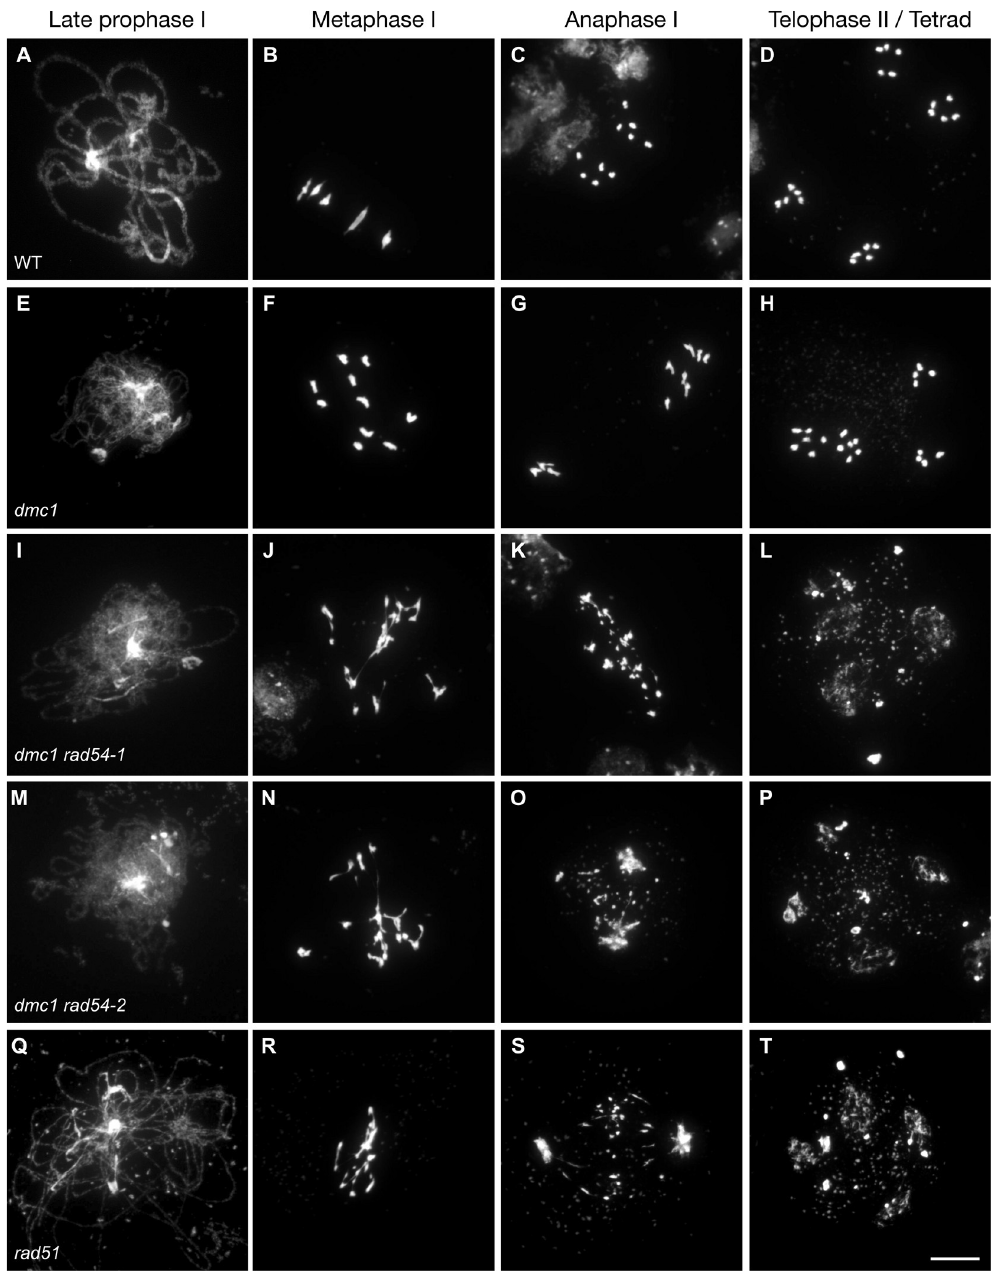
Fig 4. Absence of RAD54 leads to chromosome fragmentation in dmc1 meiosis. Male meiosis is shown in (A-D) wild- type, (E-H) dmc1 , (I-L) dmc1 rad54-1 , (M-P) dmc1 rad54- 2, and rad51 (Q-T). Chromosome spreads at late prophase I (A,E, I,M,Q), Metaphase I (B,F,J,N,R), Anaphase I (C,G,K,O,S) and Telophase II/Tetrad (D,H,L,P,T). Chromosomes were spread and stained with DAPI. (Scale bar = 10 μ m). foci were observed in rad54 (89 ± 18, n = 22) and dmc1 (97 ± 26, n = 50) single mutant plants and importantly, the numbers of RAD51 foci were also unchanged in dmc1 rad54 double mutants (94 ± 16, n = 56) (Fig 5).